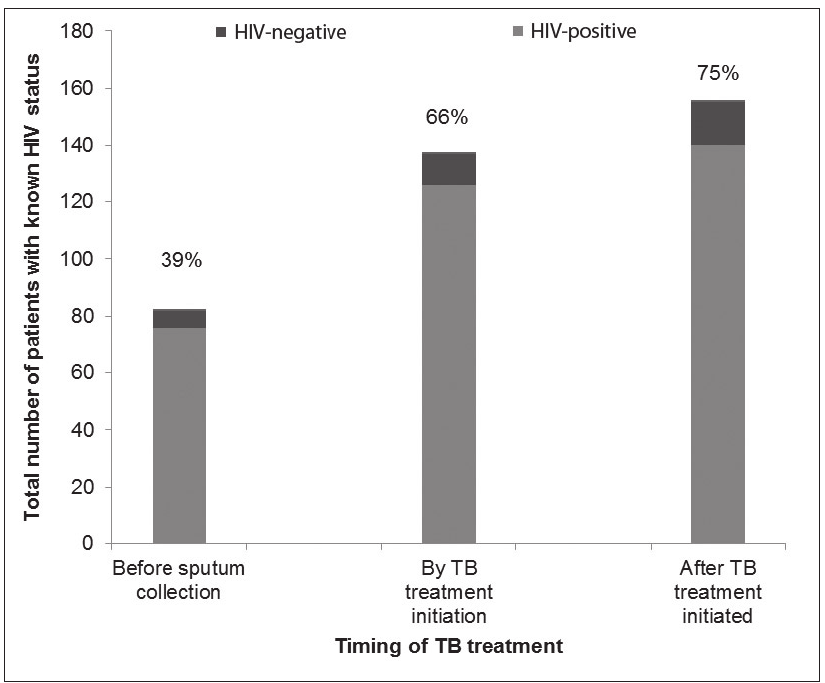
Fig 1. HIV counselling and testing among 208 TB patients registered at 3 primary care clinics in Johannesburg, South